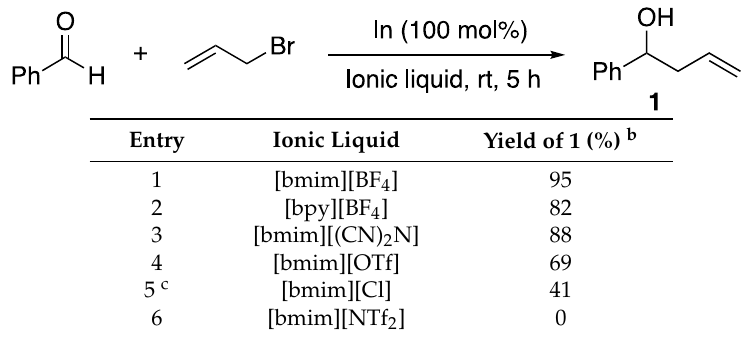
Table 1. Indium-mediated allylation in ionic liquid. a Table 1. Indium ‐ mediated allylation in ionic liquid. a